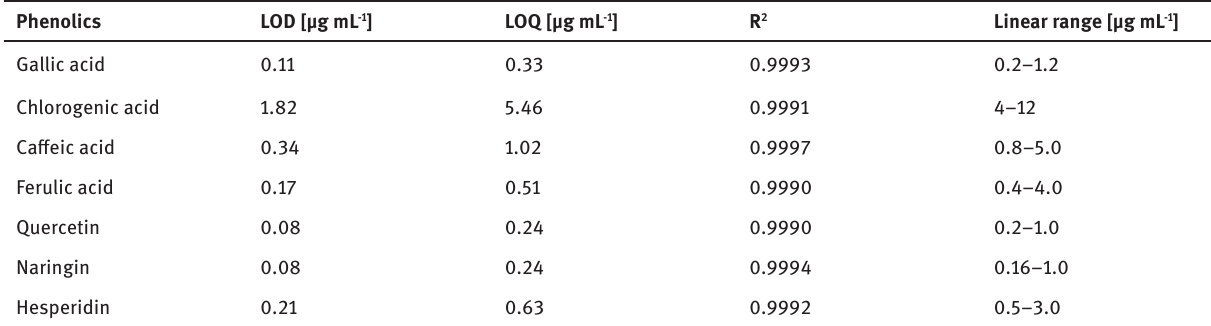
Table 2: LOD and LOQ parameters of the phenolics analysis in the daily food rations. Phenolics LOD [µg mL -1 ] LOQ [µg mL -1 ] R 2 Linear range [µg mL -1 ] Gallic acid 0.11 Chlorogenic acid Caffeic acid Ferulic acid Quercetin Naringin 0.08 0.24 Hesperidin